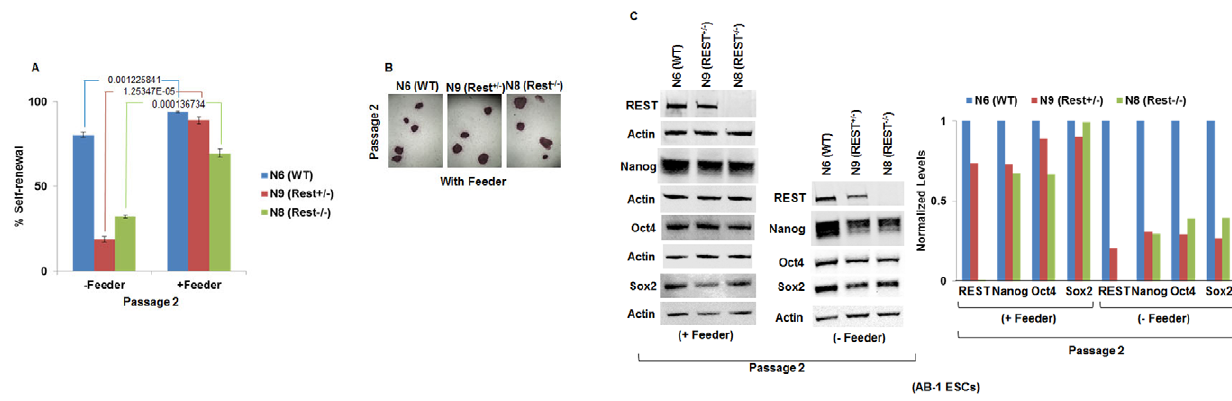
Figure 3. Extracellular cues provided by feeder cells compensate for REST-mediated loss of self-renewal and pluripotency in AB-1 ESCs. (A) Alkaline phosphatase based self-renewal assays of AB-1 parental, Rest + / 2 and Rest 2 / 2 ESCs in the presence of LIF but in the presence or absence of feeder cells shows that Rest + / 2 and Rest 2 / 2 cells have lower self-renewal efficiency compared to the parental line in the absence of feeder cells, but no large difference in the presence of feeder cells. The numbers under the lines show p-values (n=3). Error bars are standard error of means. (B) Representative pictures of AP-stained colonies of parental and Rest 2 / 2 cells in the presence of feeder layer. (C) Western blotting assays to detect level of REST and the core self-renewal regulators Oct4, Sox2, and Nanog (left panel: Western blot, right panels: quantification of western blot) confirmed that the feeder cells compensated for the loss of self-renewal and pluripotency in Rest + / 2 and Rest 2 / 2 AB-1 ESCs. Experiments were performed as described in Figure 2D.